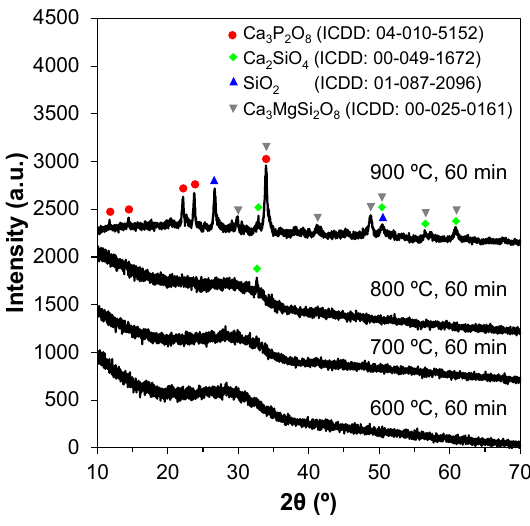
Figure 2. Effect of calcination temperature on glasses produced via the sol–gel method. Crystalline phases appear at 900 °C.